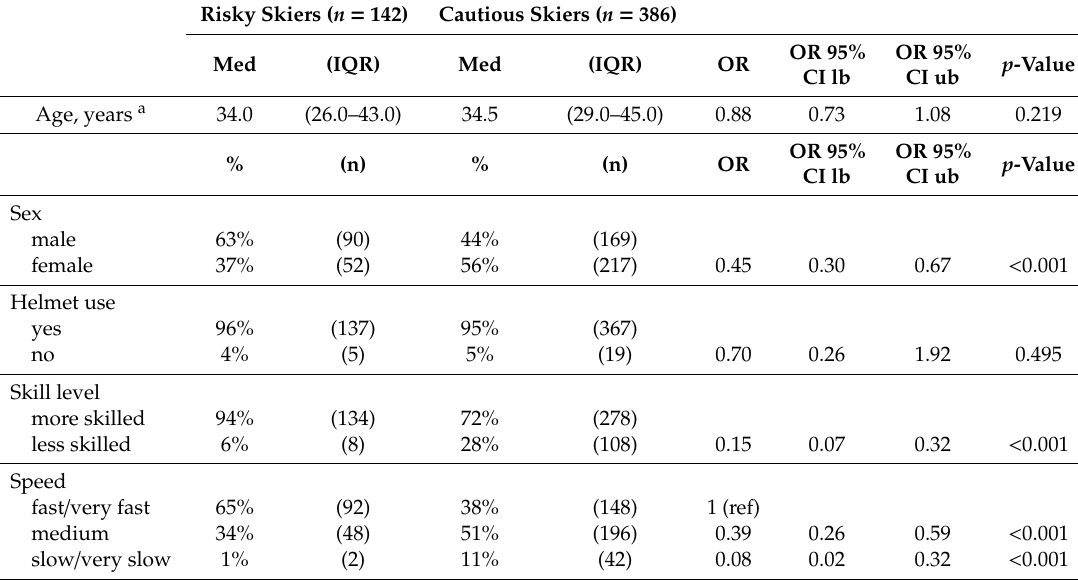
Table 1. Simple regression analysis regarding factors associated with the dependent variable risk-taking behavior (0: more risky, 1: more cautious) on ski